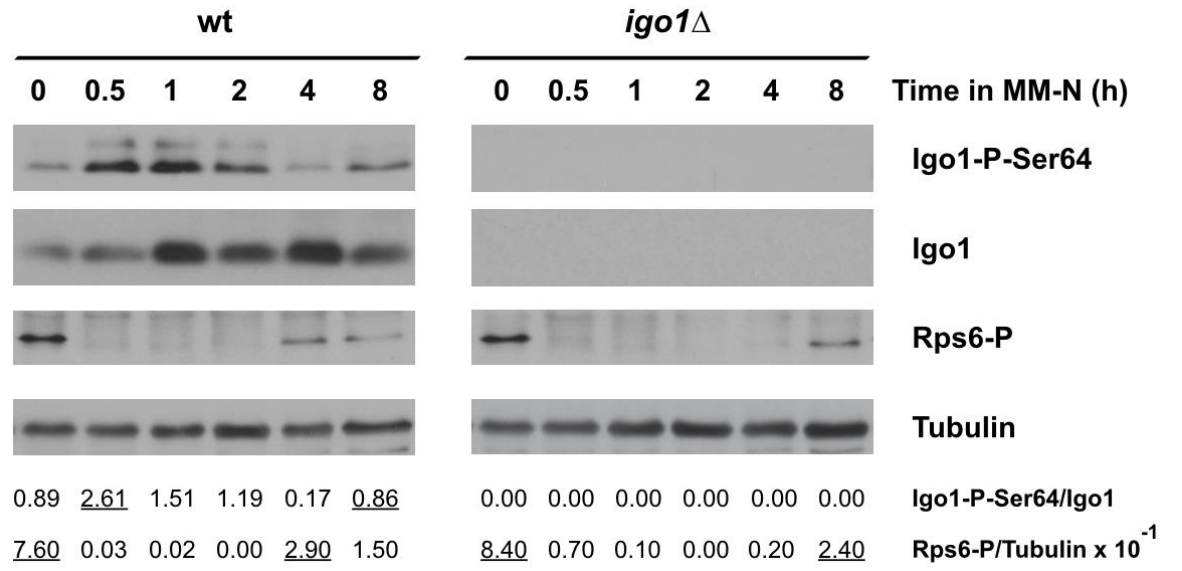
Figure 2. TORC1 and Greatwall activity oscillate out of phase during nitrogen starvation. Wild type and igo1 ∆ cells grown in minimal medium at 25 ◦ C until mid-exponential phase were transferred to nitrogen-free minimal medium (MM-N) for 8 h at 25 ◦ C. Samples were taken at 0, 0.5, 1, 2, 4, and 8 h in MM-N. Greatwall and TORC1 activities were determined using specific anti-phospho-Ser64-Igo1 and anti-Rps6-Ser235/236 antibodies. Igo1 protein levels were determined using anti-Igo1 antibodies. Tubulin was used as a loading control. The Igo1-P/Igo1 and Rps6-P/Tubulin ratios are indicated under the gels. Underlined numbers correspond to the peaks of activity.